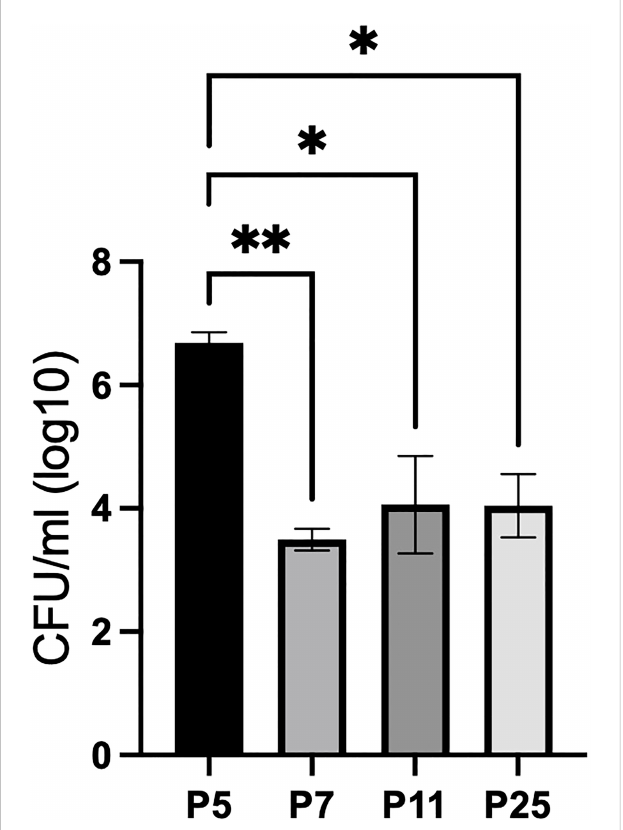
FIGURE 1 P5 C57BL/6J pups are signi fi cantly more susceptible to WT Bp than P7, P11, and P25 mice at 3 dpi (lungs). Mice were intranasally inoculated with 10 4 CFU in 15 m l (P5, P7, and P11) or 50 m l (P25). Error bars show standard error of the mean, n=4. Statistical signi fi cance was calculated via One-way ANOVA. *p<0.0332,